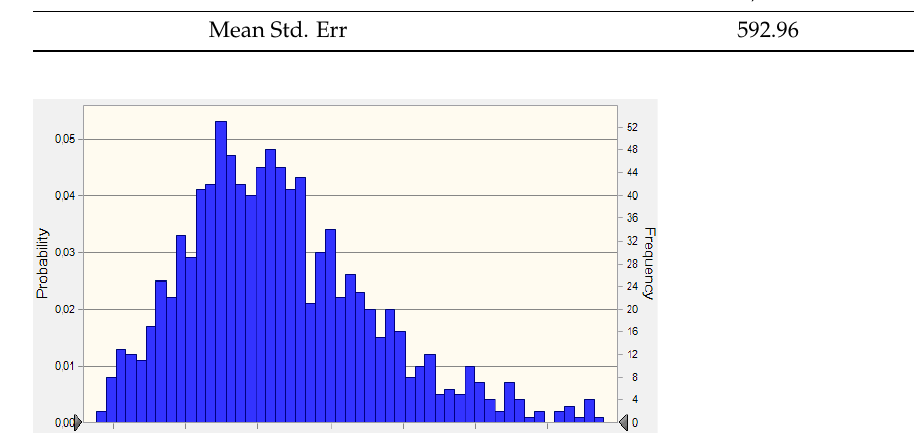
Table 12. Descriptive statistics of the probability distribution of the present value of incomes from the accommodation rental facilities for 10 years in the region of Poprad–Vysoké Tatry.